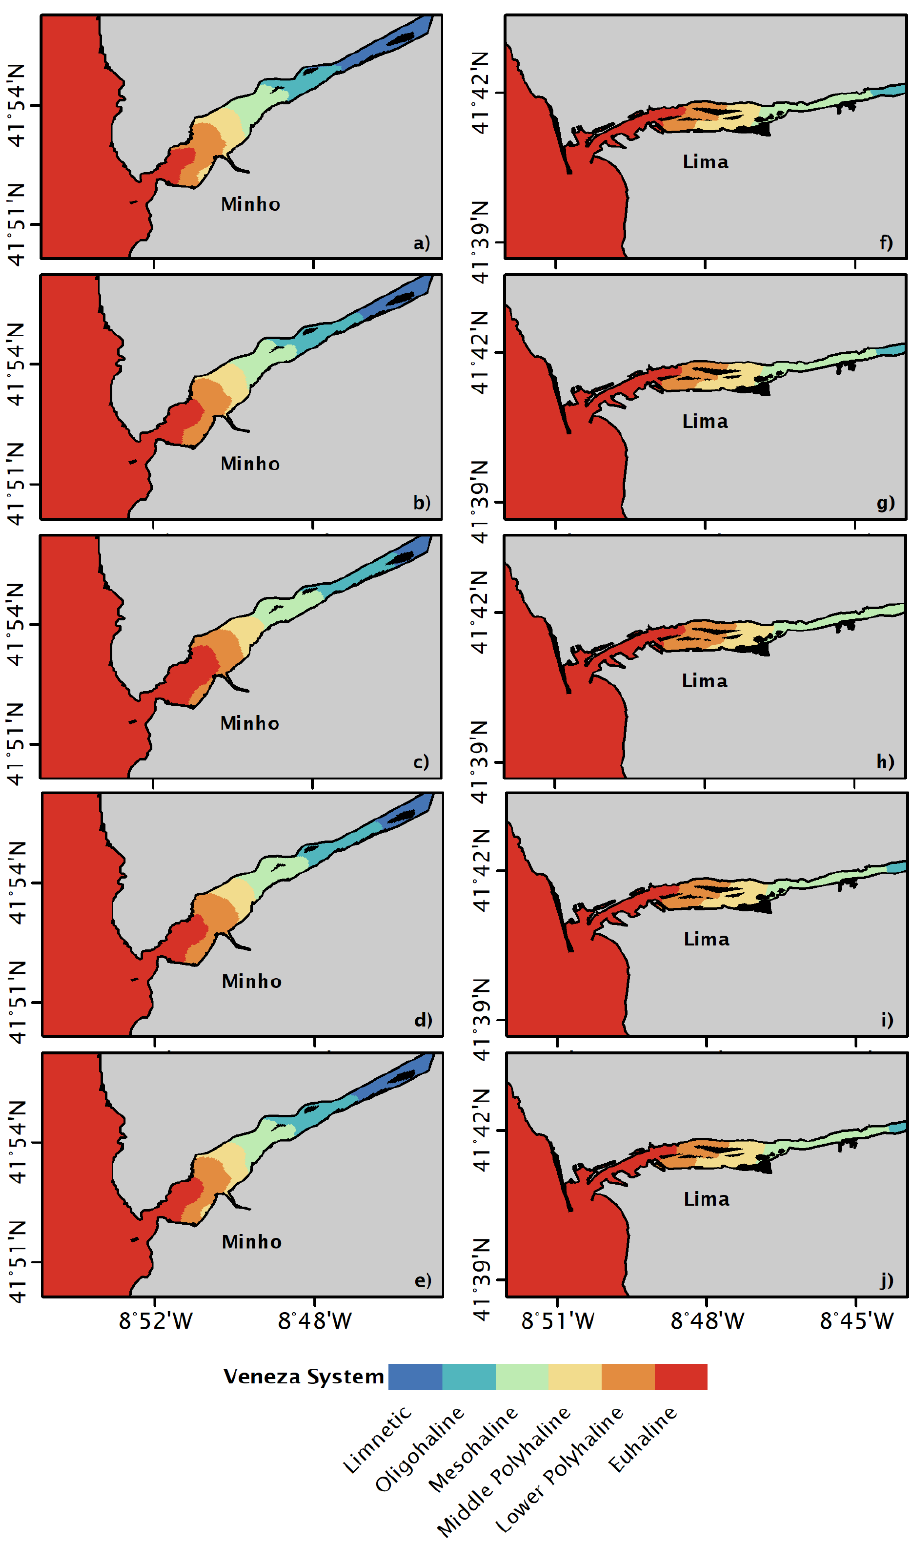
Figure 3. Salinity distribution based on Venice system during winter conditions for the scenarios Present ( a , f ), RCP 4.5 ( b , g ), RCP 8.5 ( c , h ), RCP 8.5 SL ( d , i ), and RCP 8.5 RD ( e , j ). The left panel represents the Minho estuary and the right panel the Lima estuary.